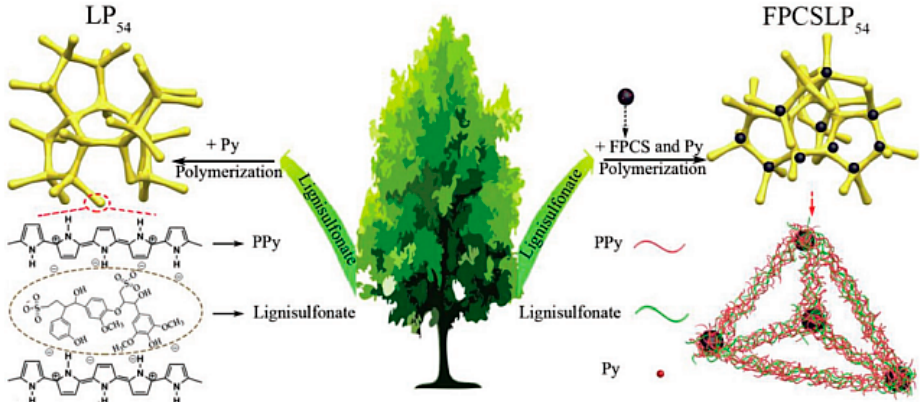
Figure 7. Schematic representation of the preparation of LP 54 and FPCSLP 54 . Reprinted with permission from ref. [50]. Copyright 2019 John Wiley & Sons. permission from ref. [50]. Copyright 2019 John Wiley &